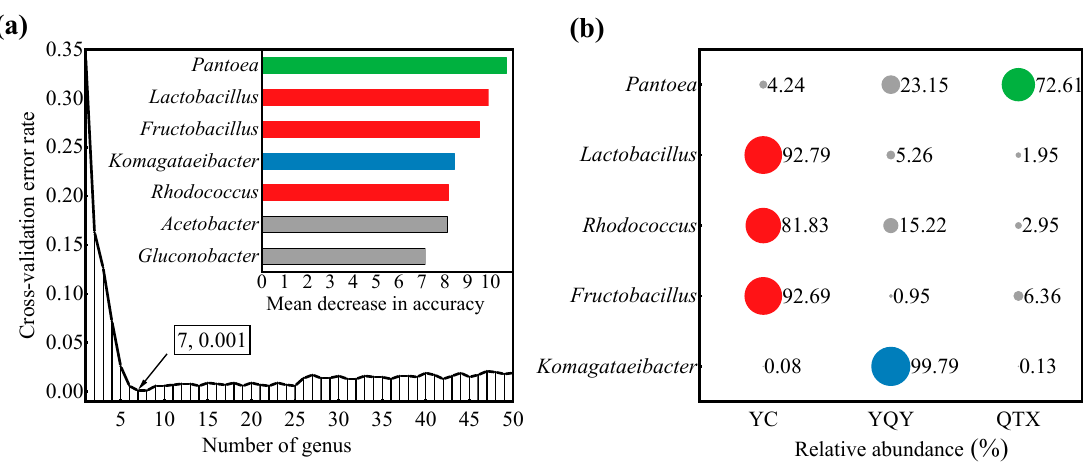
Figure 4. Core bacteria at the genus level of the Eastern Foot of Helan Mountain. ( a ) A RF model based on a 10-fold cross-validation test was constructed with 500 trees, using taxonomic assignments of genera as predictors and regional origin as class labels. When the bacterial number at the genus level was 7, the RF error reached the lowest value (0.001). The bar plot of variable importance at genus level: X -axis, bacterial importance measurement/standard deviation; Y -axis, bacterial name; ( b ) the percentages of the five core bacteria in three sub-regions. The color of each dot corresponds to the color of each bar in Figure 4a. The size of the circle represents the proportion of each bacterial genus in different sub-regions.